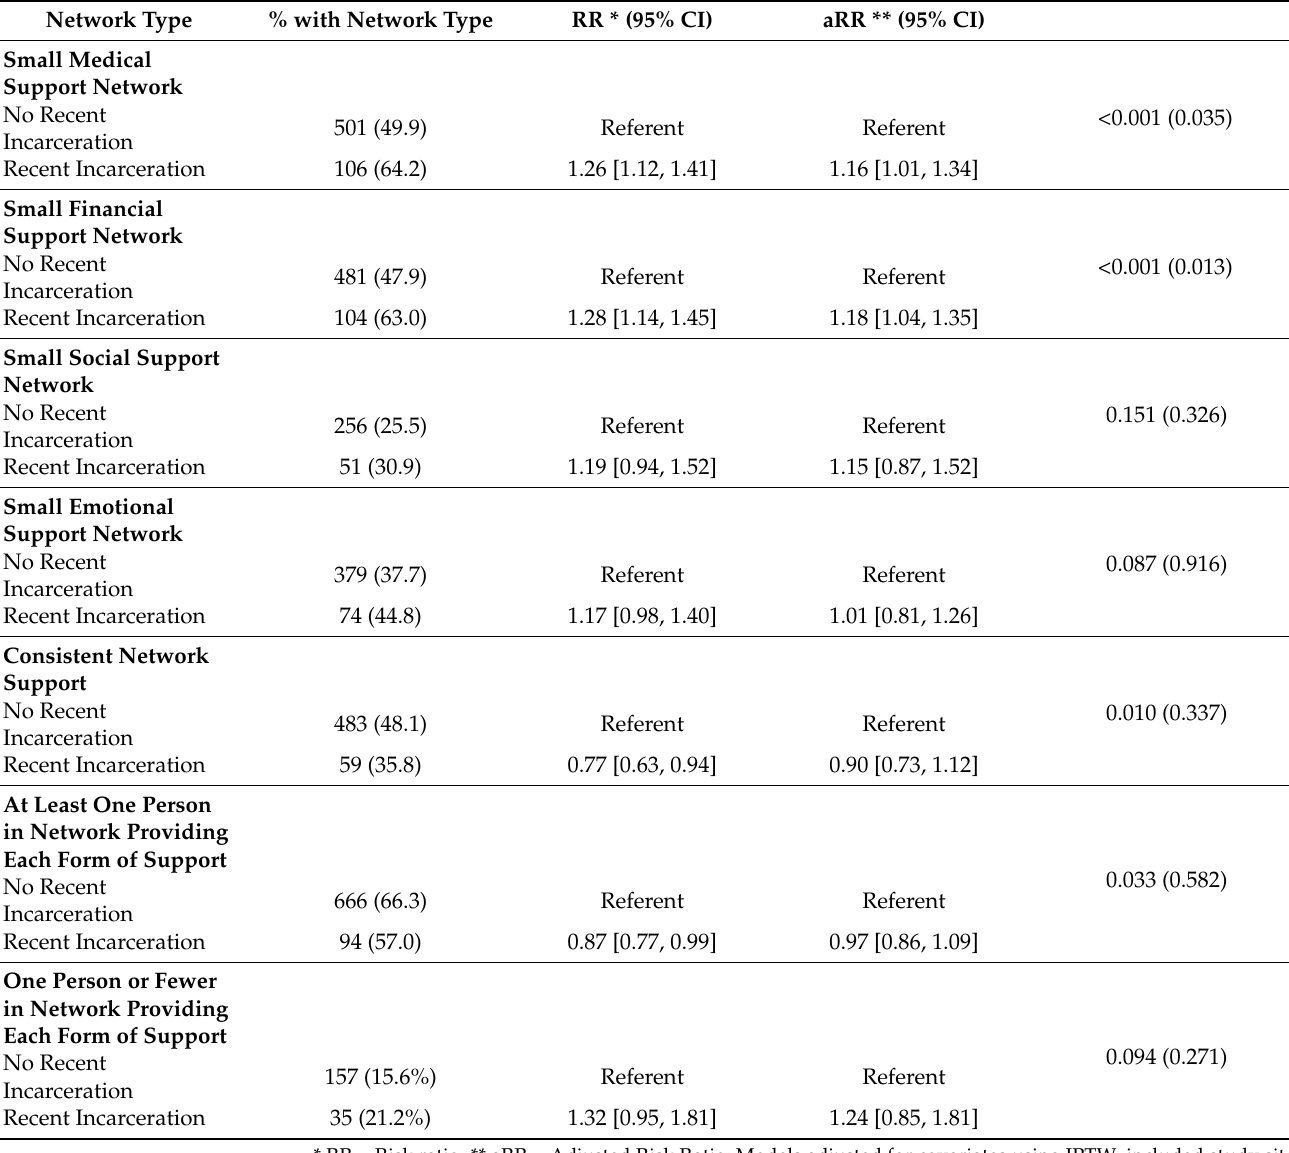
Table 2. Associations between Recent Incarceration and Types of Networks at 12 Months Follow Up (N =